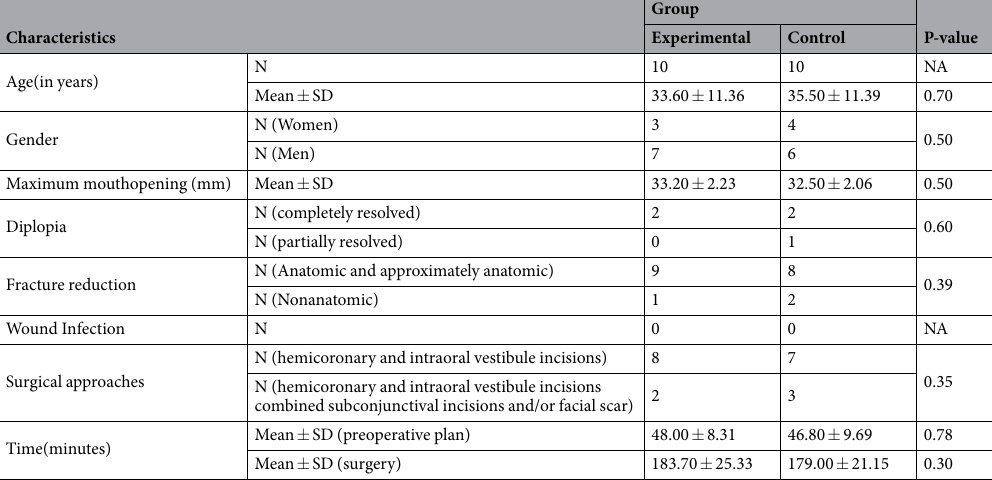
Table 1. Comparison of clinical characteristics of patients between the two groups. Using the independent- sample t-test for comparison of the postoperative maximum mouth opening and time. Using a chi-squared test (Fisher exact probability method) for comparison of the other variables; P value of < 0.05 was considered to indicate a statistically significant difference.